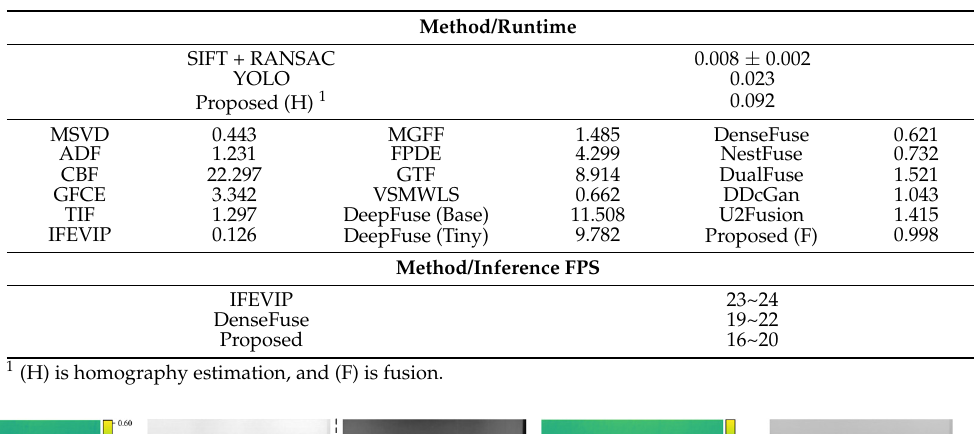
Table 3. Efficiency comparison of registration and fusion.